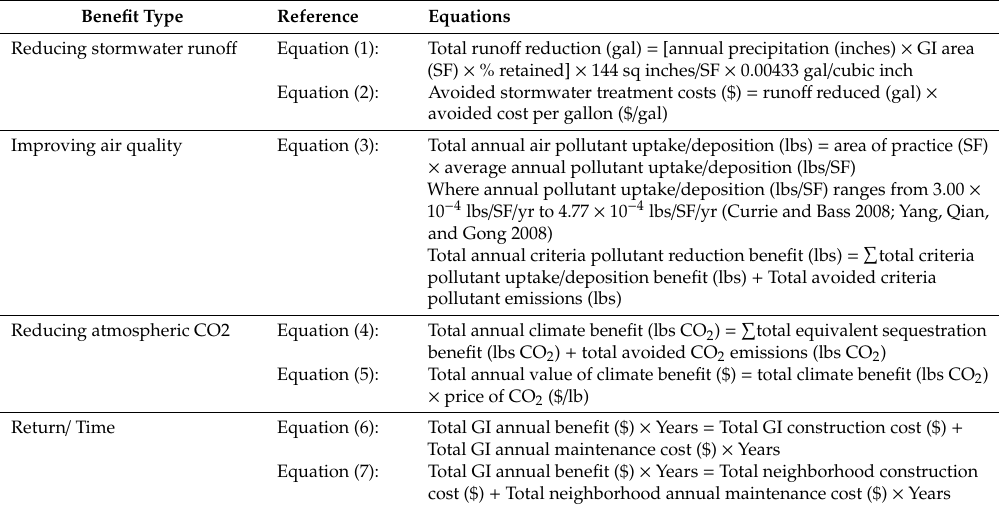
Table 2. Green infrastructure benefit quantification and valuation equations for the